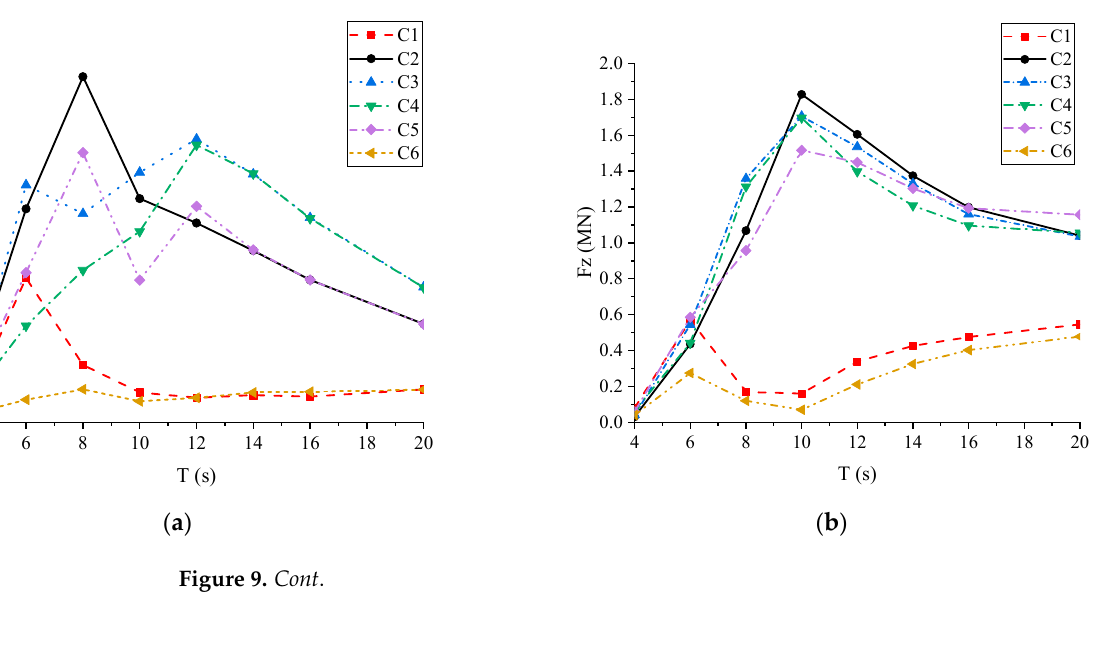
Figure 8. Main motion responses of each hexagonal module versus wave periods: ( a ) surge; ( b ) heave; ( c ) pitch. The main connector loads of each connector versus wave periods are presented in Figure 9. Main connector loads (the Fx, the Fz and the My) of the two outermost connectors (C1 and C6) were significantly less sensitive to the wave period than those of the other connectors, especially for the wave period larger than 8 s. It may be beneficial for the ultimate design of the outermost connectors. The Fx, the Fz and the My of the inner connectors almost presented the same trend, which first increased rapidly and then decreased steadily with the increase in the wave period. The peaks of the main connector loads for different connectors occurred in the wave period range from 6 s and 12 s, due to the coupling effect between different degrees of freedom. In addition, it should be noted that both the Fx and the Fz of the head-wave C2 were the largest among the connectors, corresponding to wave peak periods of 8 s and 10 s, respectively. The My of both the two fixed connectors (C3 and C4) were much larger than those of the others, corresponding to the wave peak period of 10 s.